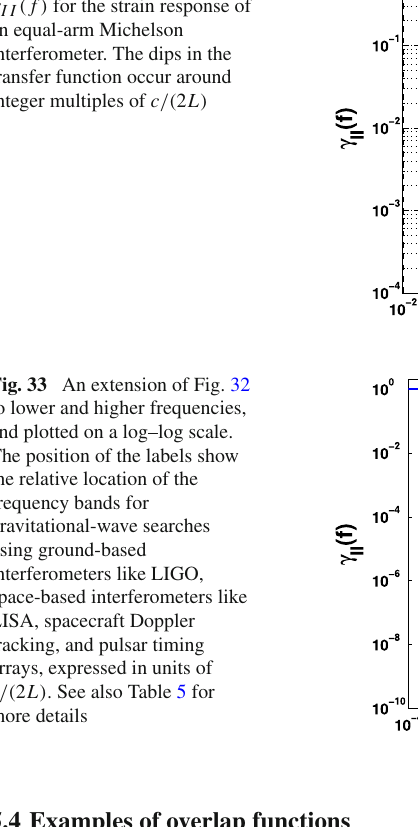
Fig. 32 A plot of the normalized transfer function γ ( f ) for the strain response of II an equal-arm Michelson interferometer. The dips in the transfer function occur around integer multiples of c /( 2 L )